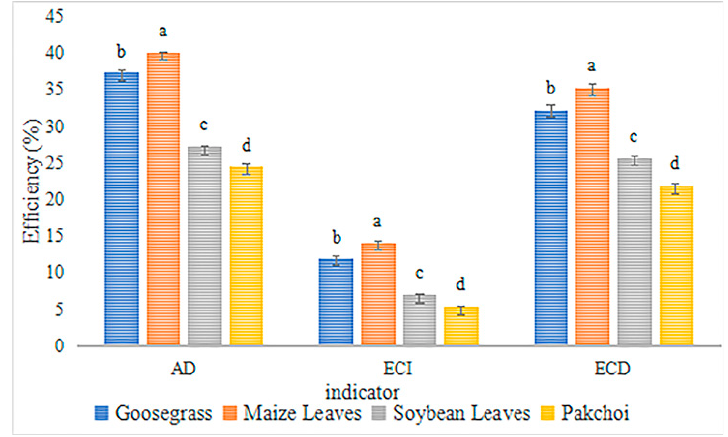
Table 2. Developmental durations of L. migratoria manilensis reared on four food plants.